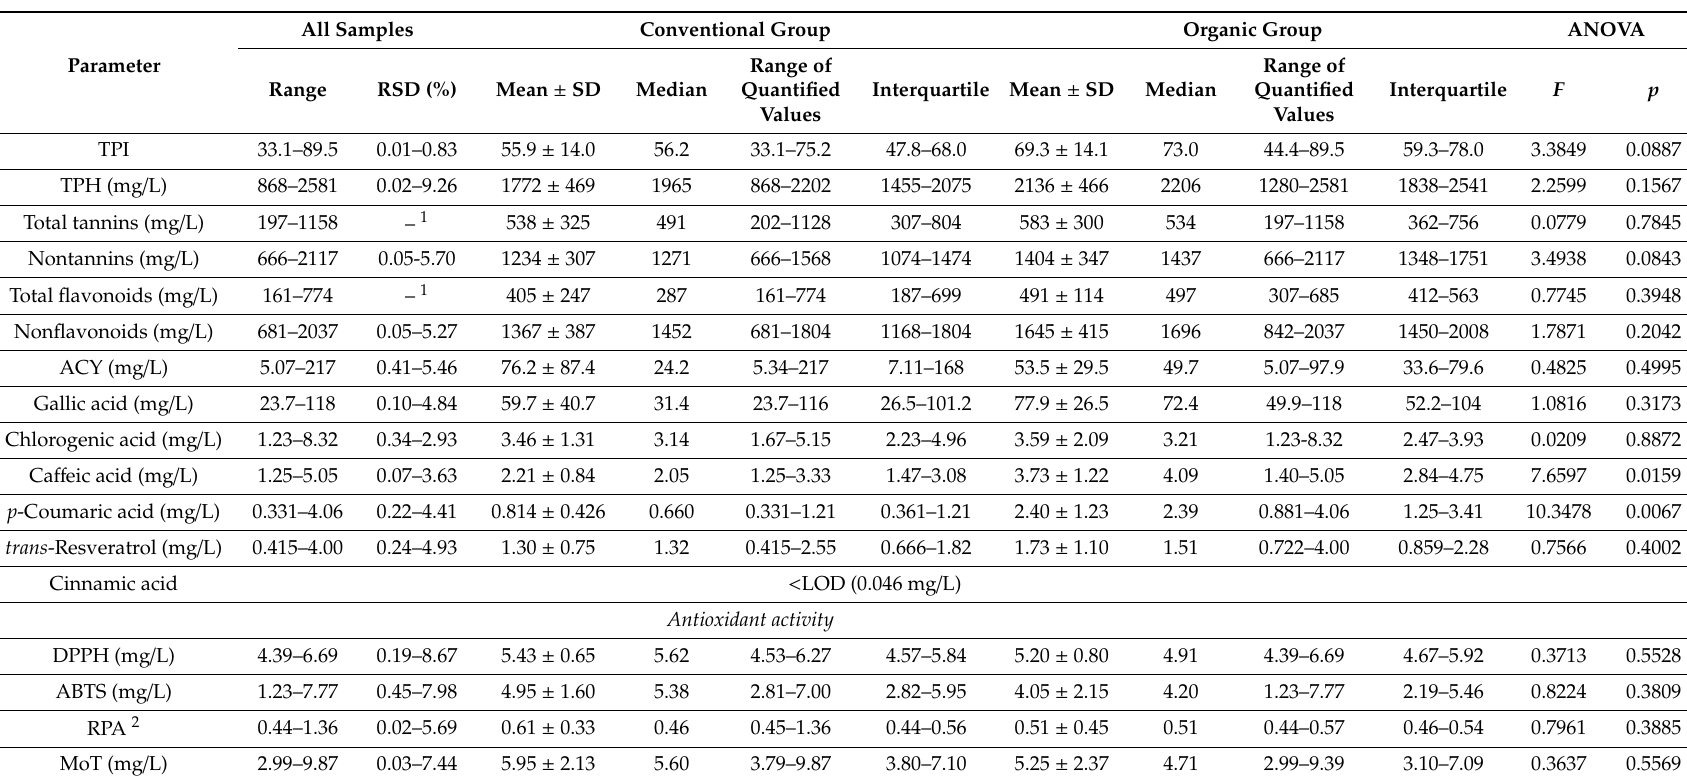
Table 2. Descriptive statistical analysis of polyphenol content and antioxidant activity in conventional and organic BW